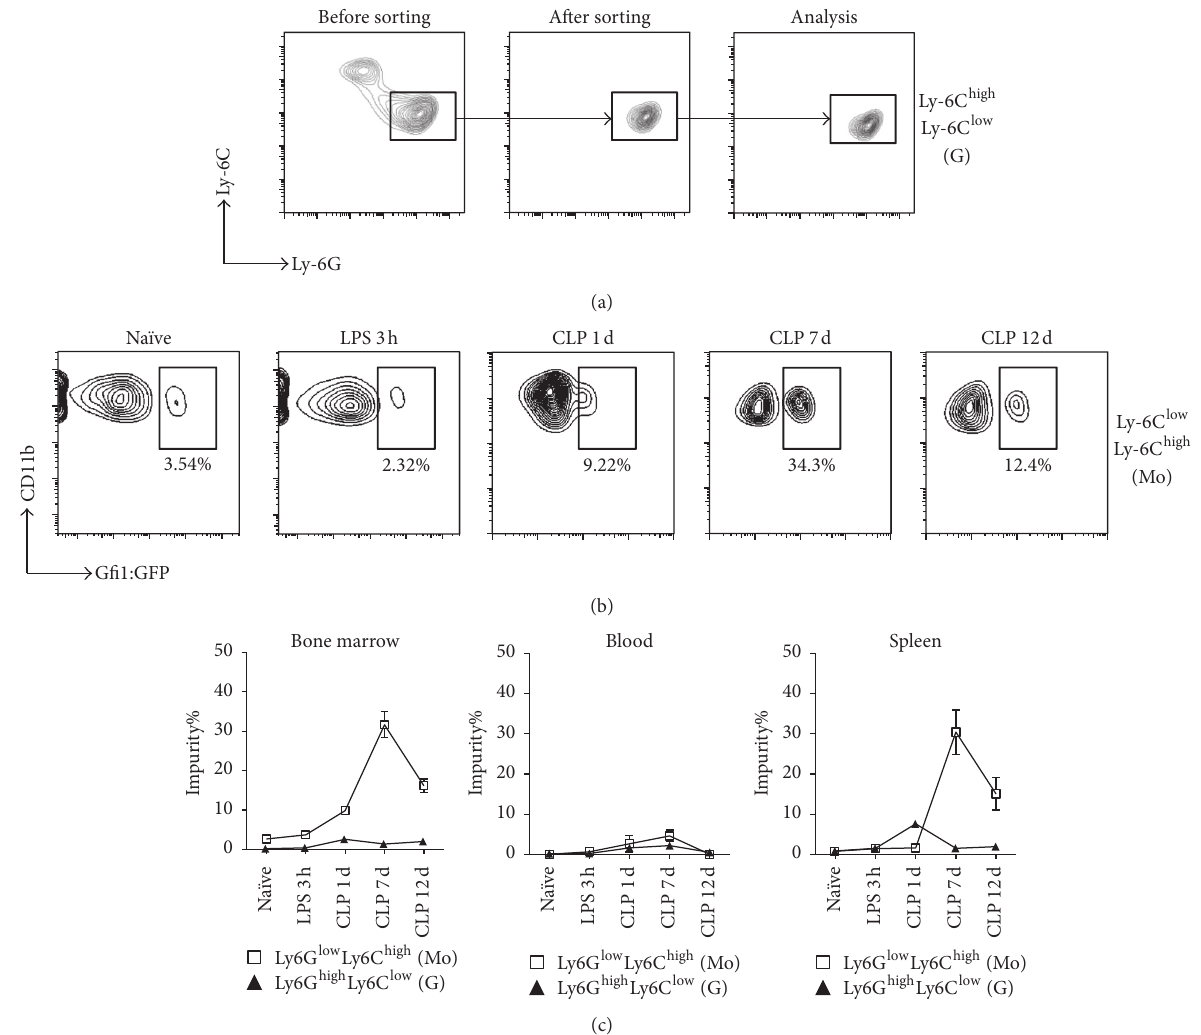
Figure 2: Influence of inflammation on Ly6C and Ly6G expression in MDSC subsets. (a) Sorted CD11b + Ly 6 G high Ly 6 C low G-MDSCs from the bone marrow of wild-type mice were cultured with LPS (100ng/ml) in vitro for 3 h, collected, and assayed by FACS. Representative graphs of flow cytometry analysis are shown. (b) Gfi1:GFP knock-in mice were exposed to LPS (i.p. 10 mg/kg) or CLP surgery. Bone marrow, spleen, and blood cells were stained with fluorescence-conjugated antibodies after 3h LPS and on days 1, 7, and 12 after CLP. M-MDSCs were gated as CD11b + Ly 6 G low Ly 6 C high and their purity was evaluated by Gfi1:GFP expression (graphs of bone marrow are shown). (c) Statistical analysis of flow cytometry data. Data are mean ± SEM of 5–8 mice per